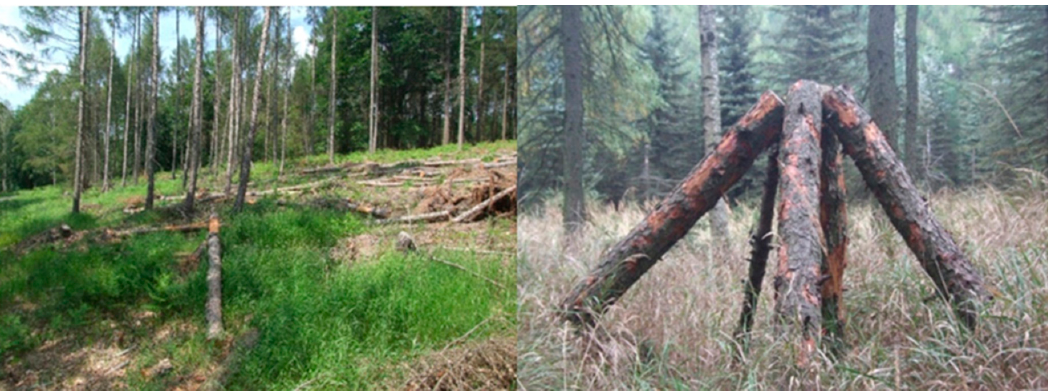
Figure 3. Larch trap tree ( left ) and pyramid-trap pile ( right ) and at the study site near Sn ě žník in 2019 (experiment 2). Photograph by Kula.